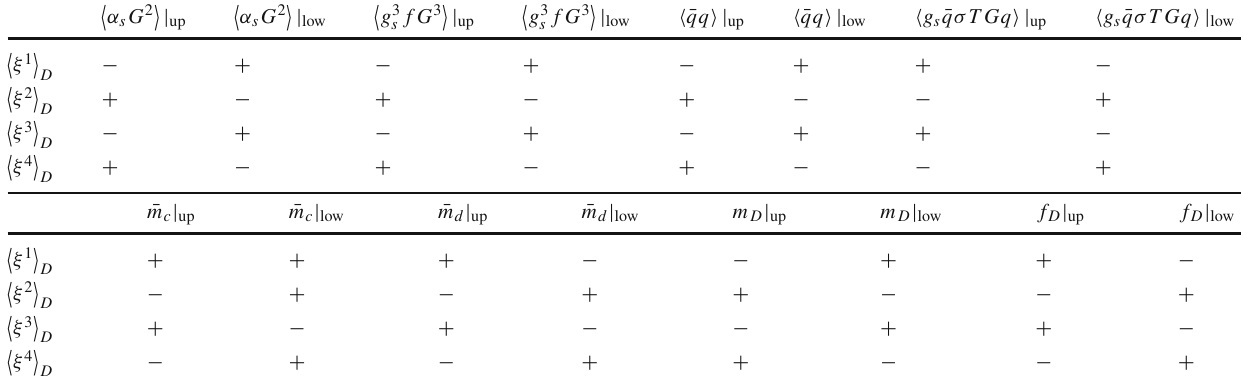
Table 3 The impact of various inputs on (cid:3) ξ n (cid:4) D . The Borel parameter M is fixed to be its central value. The labels “ | up ” and “ | low ” stand for the upper and lower bounds of the inputs, and the symbols “ + ” and “ − ”